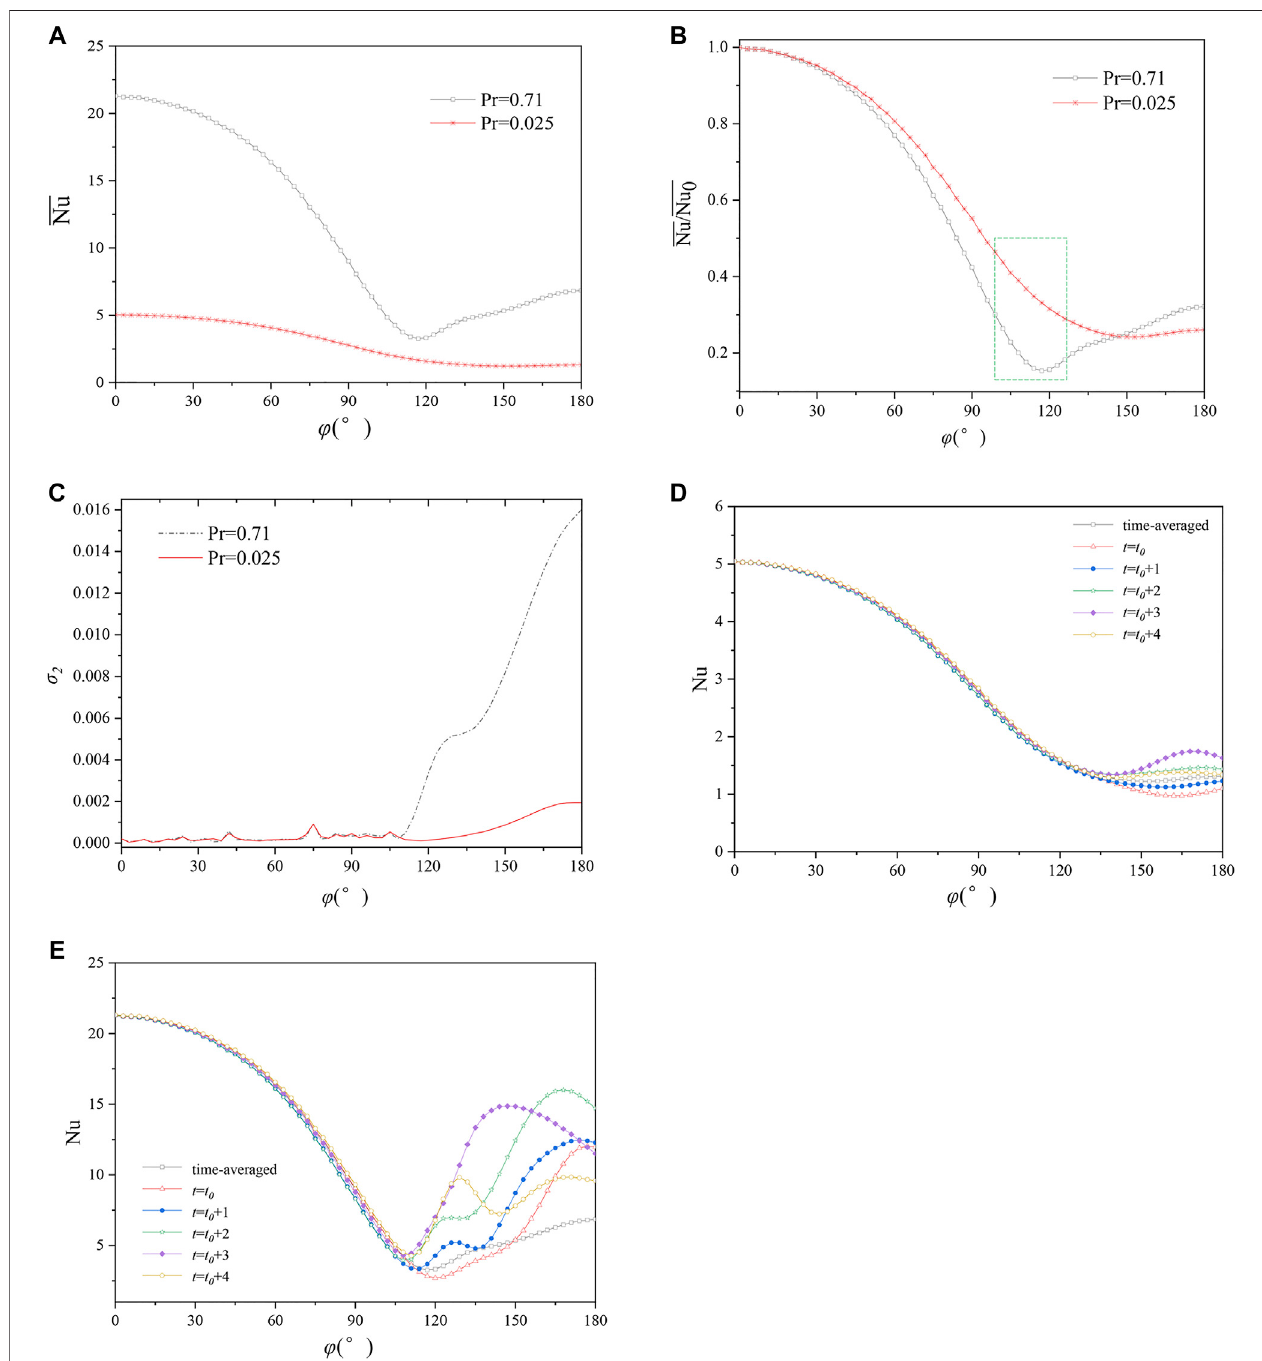
FIGURE 5 | Distribution of Nu. The fi ve instants of time in D and E are explained in Figure 3 . (A) Variation of local Nu on the cylinder surface (at z = 0 plane); (B) circumferentially variations of Nu ; (C) the spanwise standard deviation σ 2 with the angle φ ; (D) distribution of local time-averaged and instantaneous Nu for LBE Nu 0 (Pr = 0.025) (at z = 0 plane); (E) distribution of local time-averaged and instantaneous Nu for air (Pr = 0.71) (at z = 0